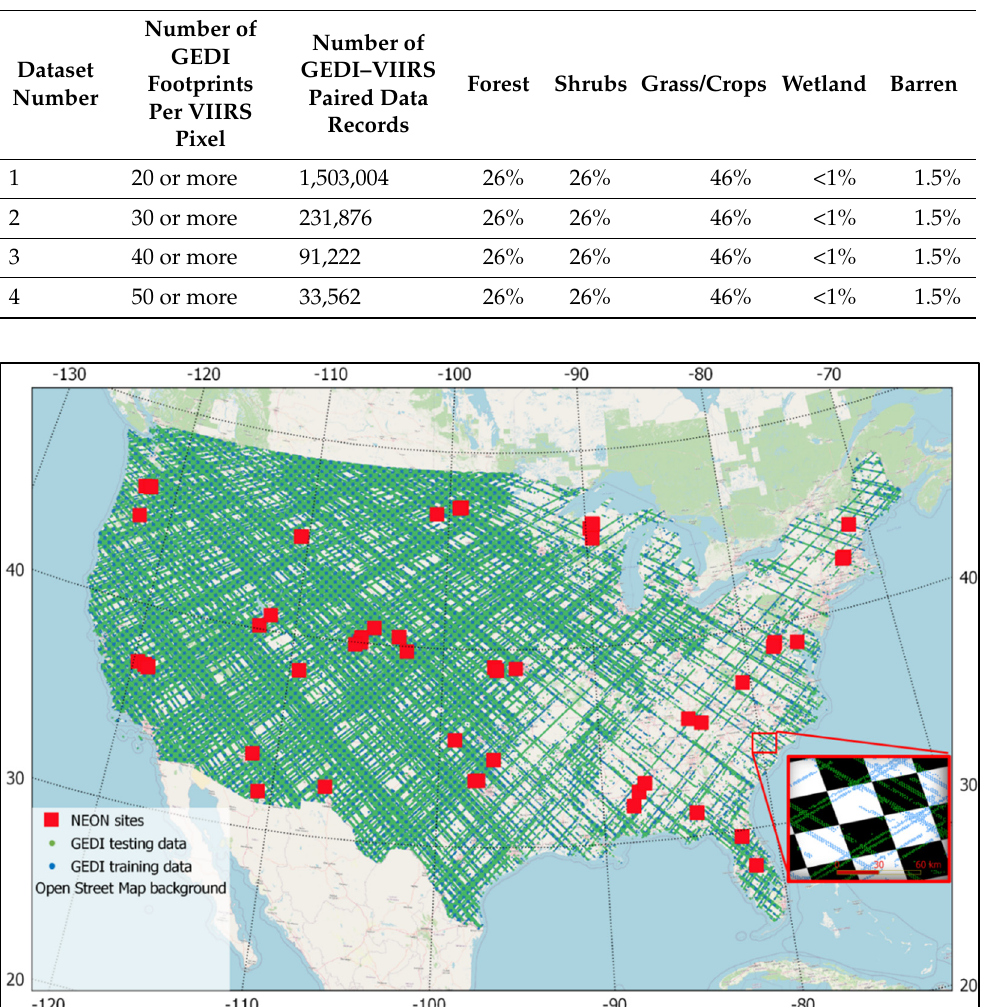
Table 6. Number of 2019 VIIRS-GEDI paired data records with 20, 30, 40, and 50 or more collocated GEDI observations retained after subsampling from the total population of GEDI–VIIRS paired data records.